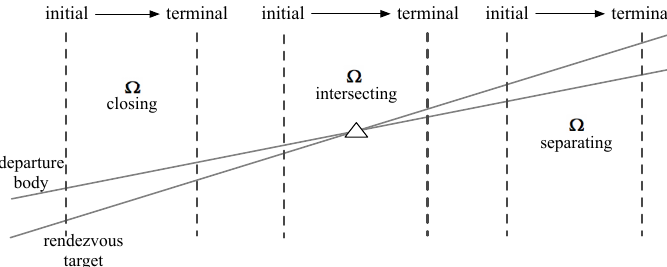
Figure 5. Variation trend of the right ascension of the ascending node ( Ω ) between the departure body and the rendezvous target for three types of perturbed multiple-impulse rendezvous.